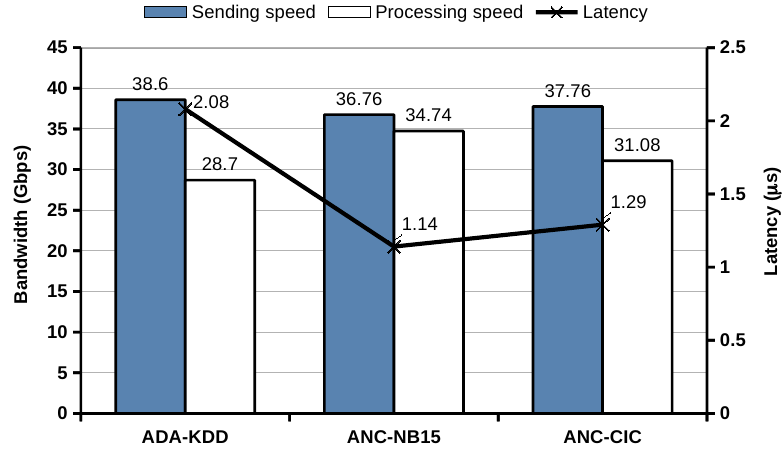
Figure 11. Bandwidth of our ADNN system with different approaches and datasets.